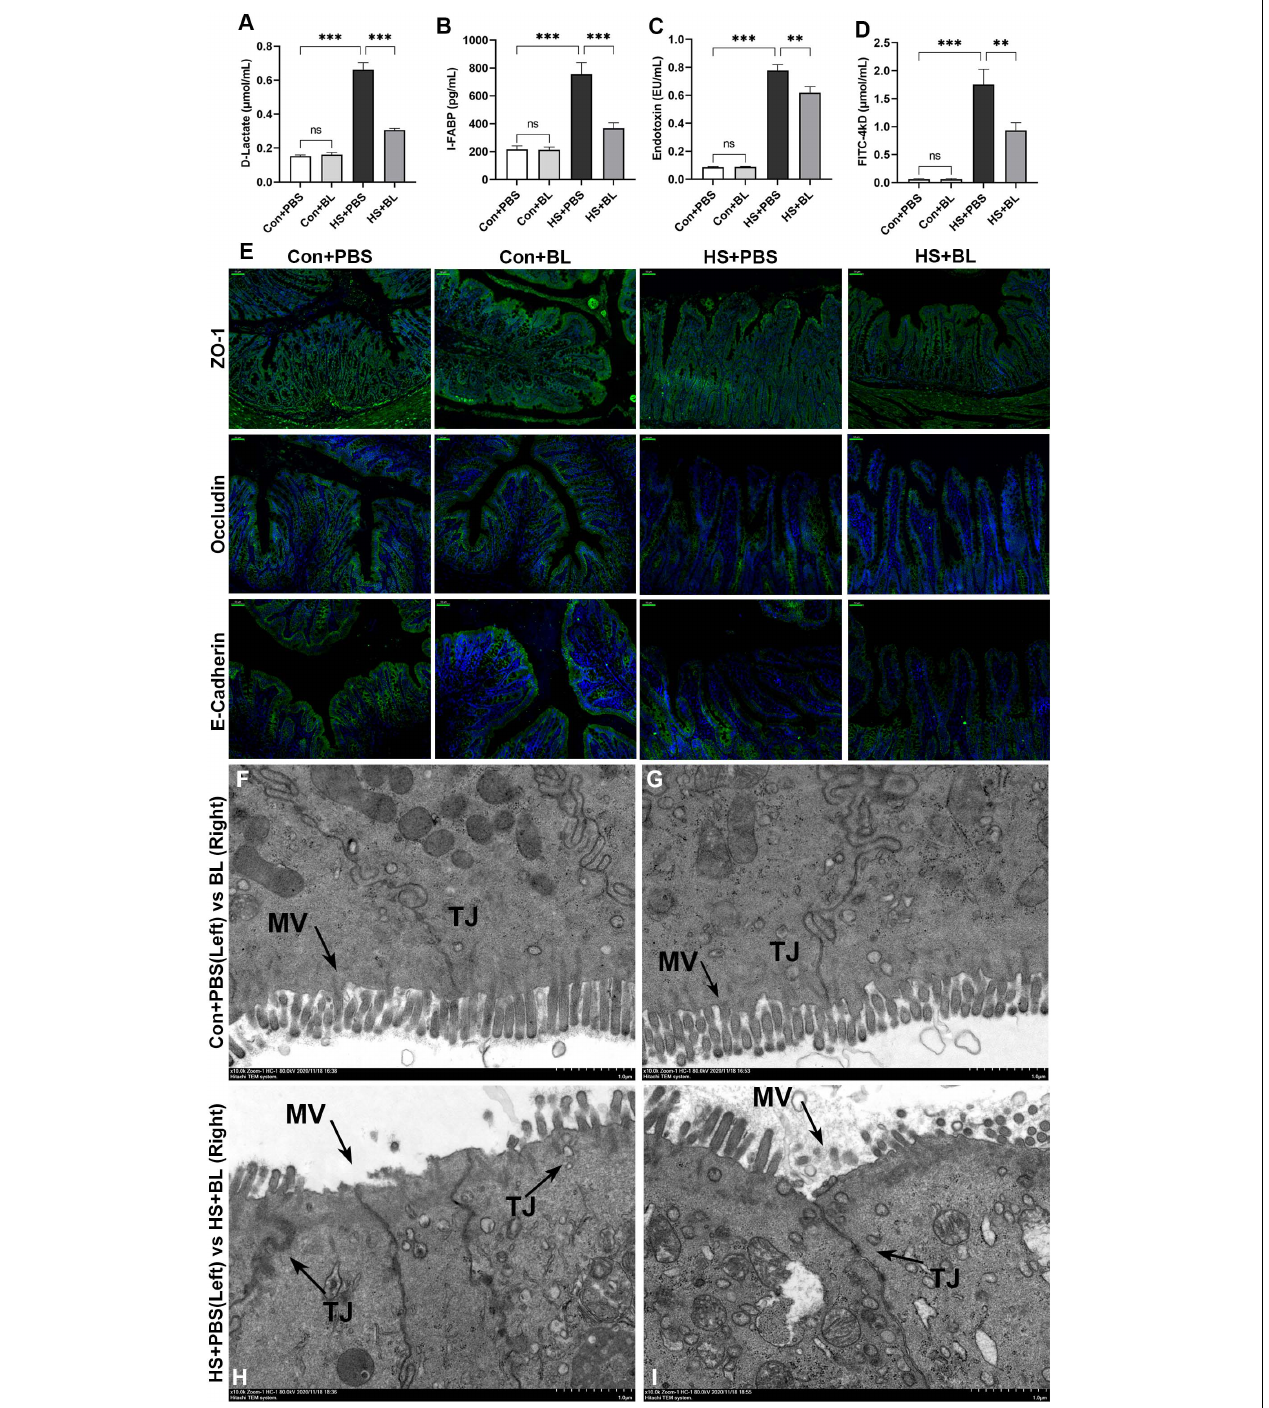
FIGURE 4 | BL pre-administration attenuated intestinal injury and enhanced intestinal barrier function. Plasma D-Lactate (A) , I-FABP (B) , endotoxin (C) , and FD4 (D) were detected at 3 h after the HS onset in the Con + PBS, Con + BL, HS + PBS, and HS + BL groups. Concentrations are presented as means ± SEM; n = 10 per group. ns P > 0.05, ∗∗ P < 0.01, ∗∗∗ P < 0.001. (E) Representative images of intestinal sections of rats from Con + PBS, Con + BL, HS + PBS, and HS + BL groups. Cell nuclei were stained using DAPI (blue), and ZO-1, occludin, and E-cadherin proteins were stained with corresponding antibodies (green). Scale bar = 50 µ m, n = 6 per group. (F–I) Representative ultrastructural transmission electron photomicrographs of intestinal samples from Con + PBS (F) , Con + BL (G) , HS + PBS (H) , and HS + BL (I) show the morphology and sizes of cell nuclei, membrane microvilli (MV, arrows), and tight junctions (TJ, arrows). Scale bar = 1 µ m. n = 3 per group.